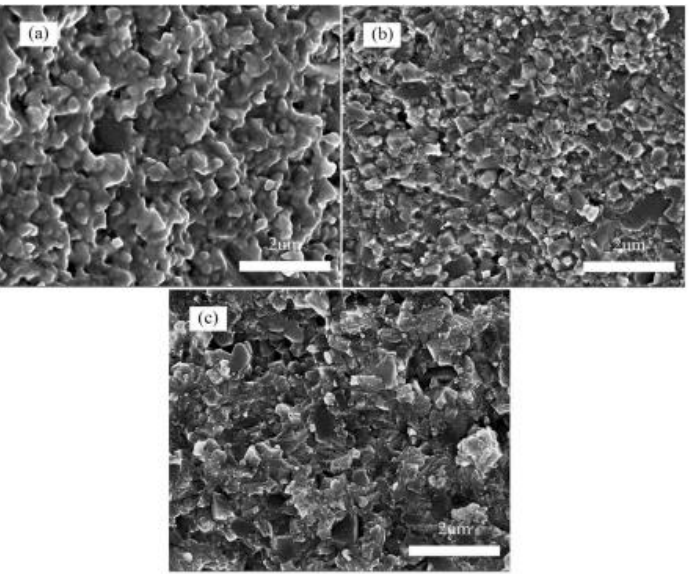
Figure 8. SEM Images of Al2O3 – ZrO2 (3Y) – SiC composite sintered at ( a ) 1300 °C, ( b ) 1350 °C and ( c ) 1400 °C [169]. ( c ) 1400 ◦ C